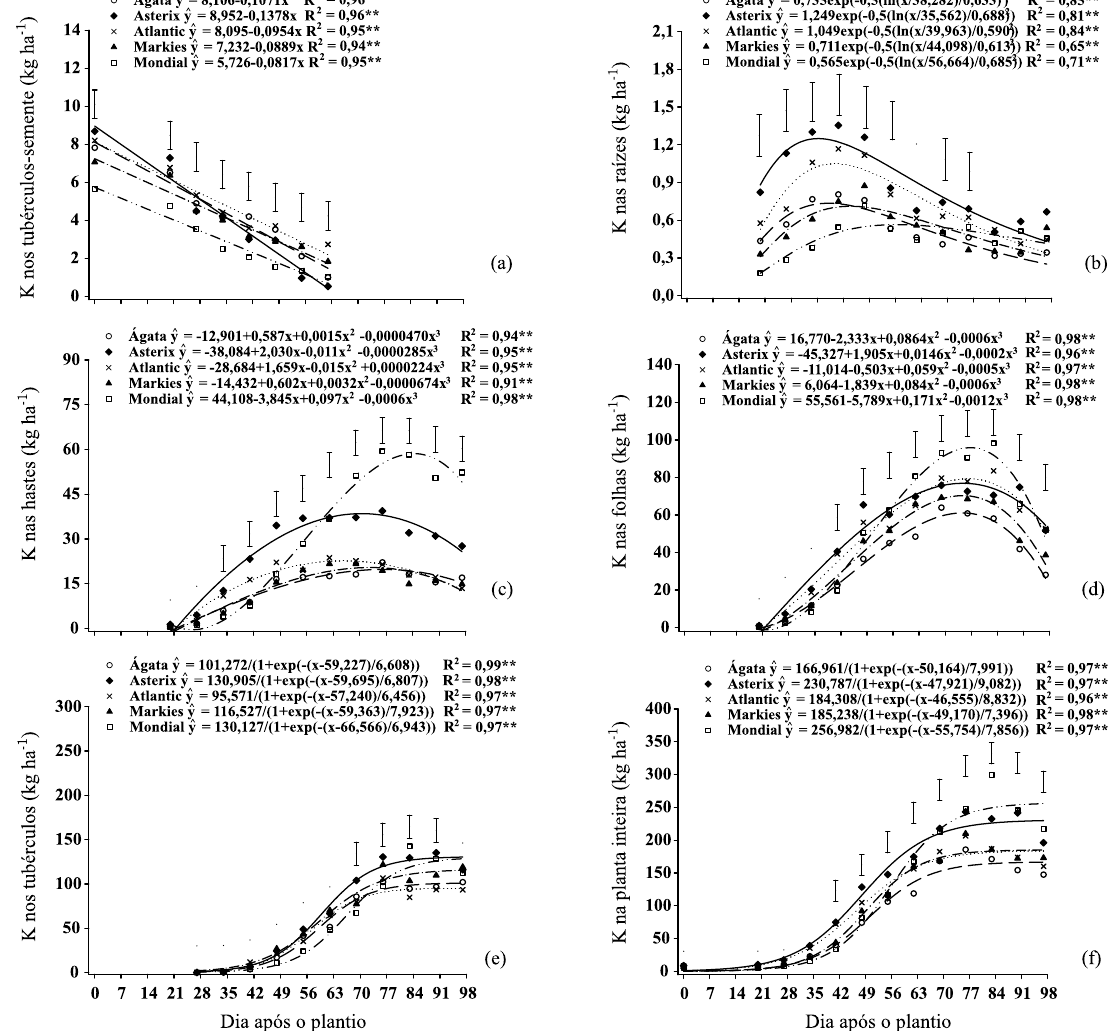
Figura 4. Quantidade de K nos tubérculos-semente (a), raízes (b), hastes (c), folhas (d), tubérculos (e) e na planta inteira (f) de cultivares de batata ao longo do ciclo. ** significativo a 1 % pelo teste F. Barras verticais indicam o valor de DMS pelo teste de Tukey a 5